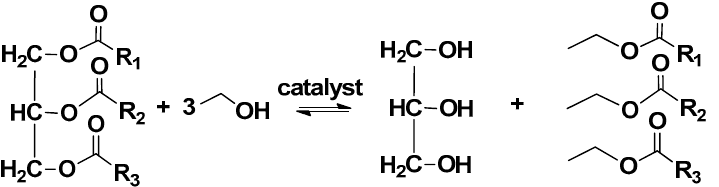
Figure 4. Transesterification reaction of a triglyceride with ethanol to give three fatty acid ethyl esters (FAEEs). esters